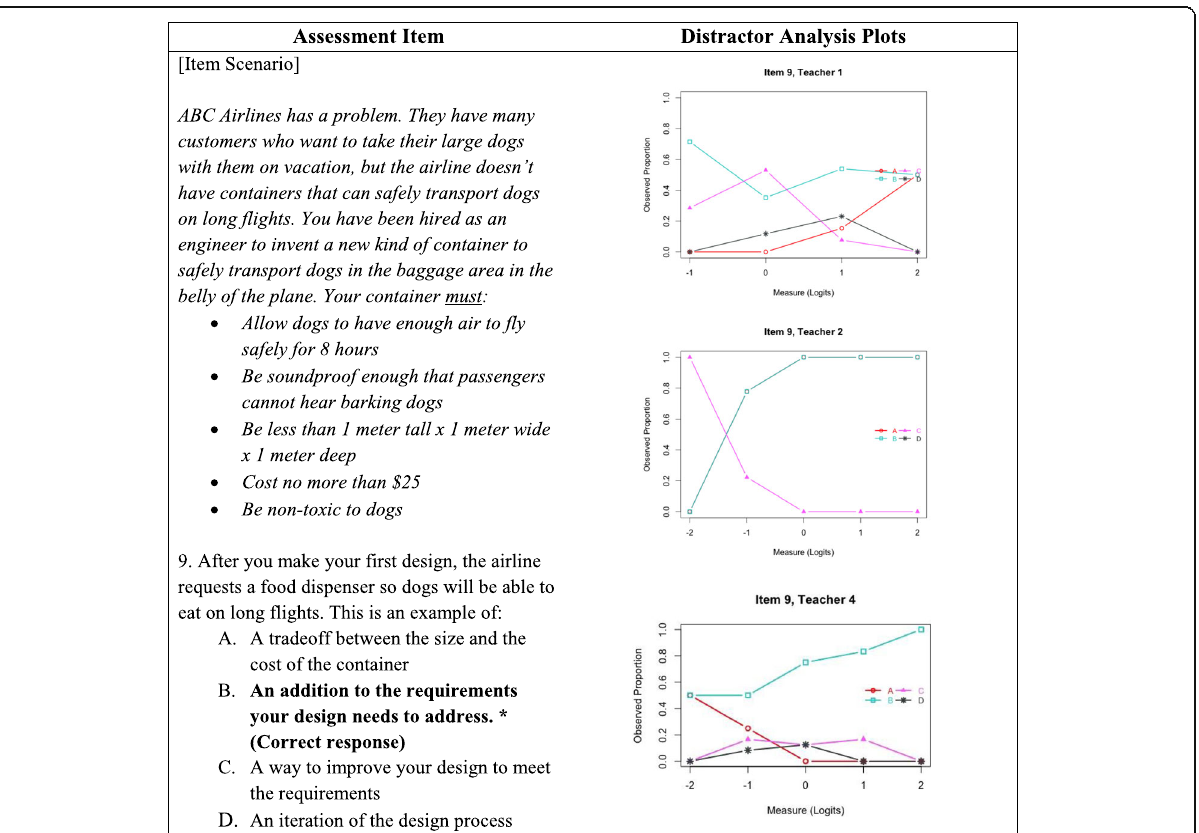
Fig. 8 Distractor analysis plot for item 9: teacher 1, teacher 2, and teacher 4. The plots in this figure show patterns of student answer choices for item 9 in teacher 1 ’ s classroom (top plot), teacher 2 ’ s classroom (middle plot), and teacher 4 ’ s classroom (bottom plot). In each plot, the x -axis displays estimates of student achievement. Student achievement estimates are shown in logits, and these estimates were calculated using the Rasch model. Low values indicate lower achievement, and high values indicate higher achievement. The y -axes shows the observed proportion of responses for a given answer choice. The lines in each plot show the proportion of students who selected each of the four answer choices (A, B, C, or D) at each level of achievement. For this item, the correct response is B (turquoise line with square plotting